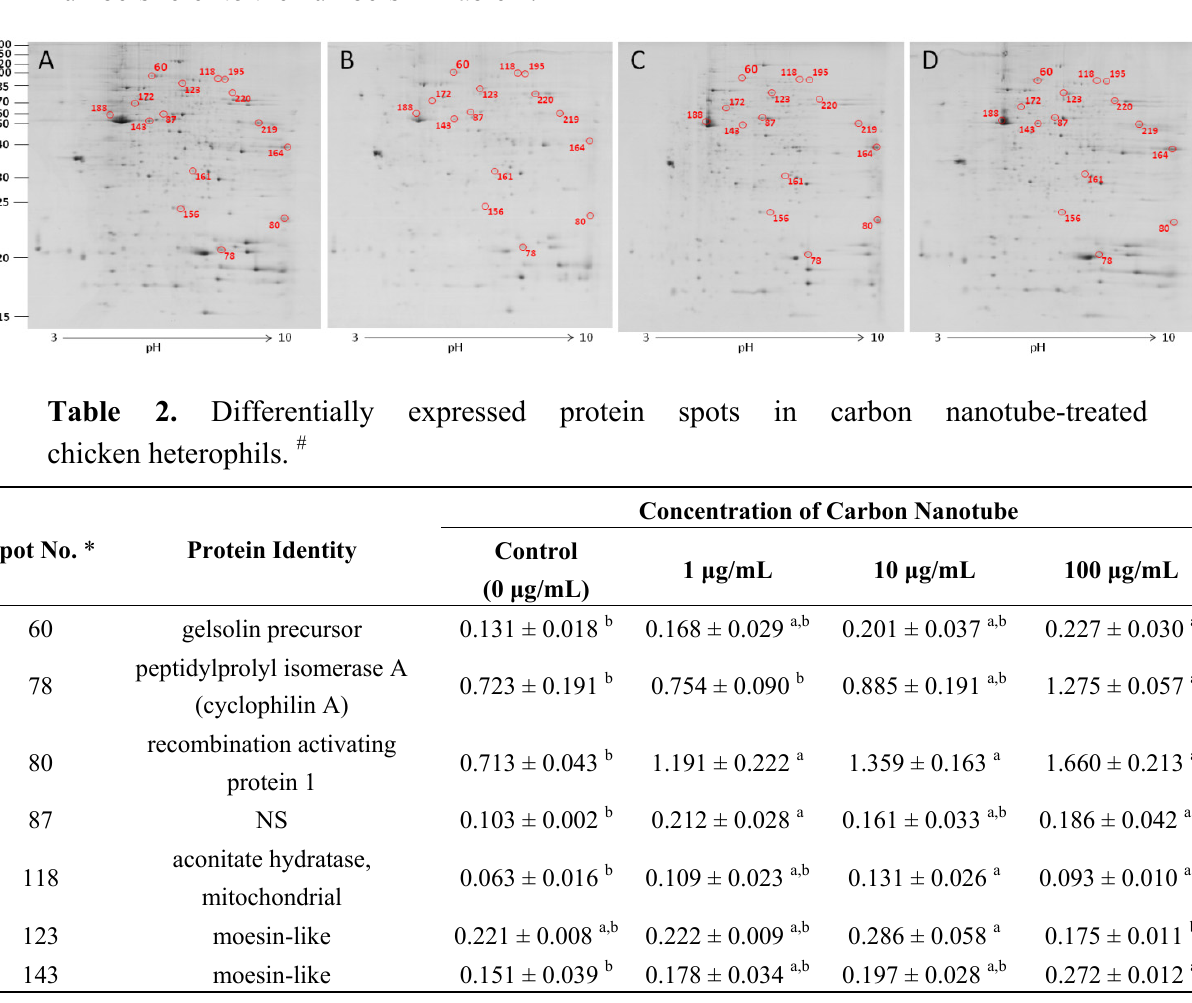
Figure 4. Protein profiles and differentially expressed spots of CNT-treated chicken heterophils. Heterophils were treated with 0 μ g/mL ( A ); 1 μ g/mL ( B ); 10 μ g/mL ( C ); and 100 μ g/mL ( D ) carbon nanotubes, then proteins were extracted for 2-DE analysis. Spot